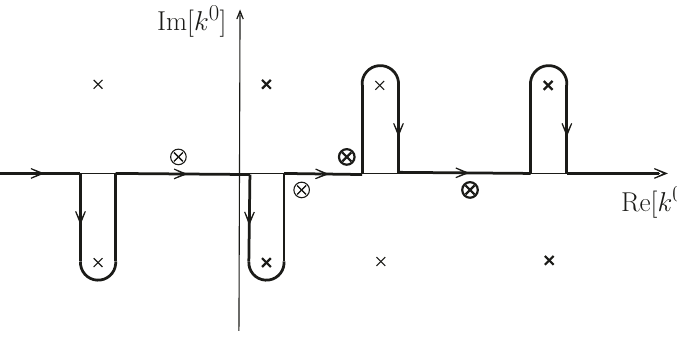
Figure 4 . Euclidean integration path of the bubble diagram.